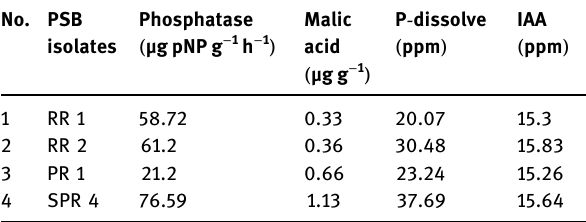
Table 2: Biochemical activity of selected PSB to produce phosphatase enzyme, malic acid, P - dissolve and IAA No. PSB isolates